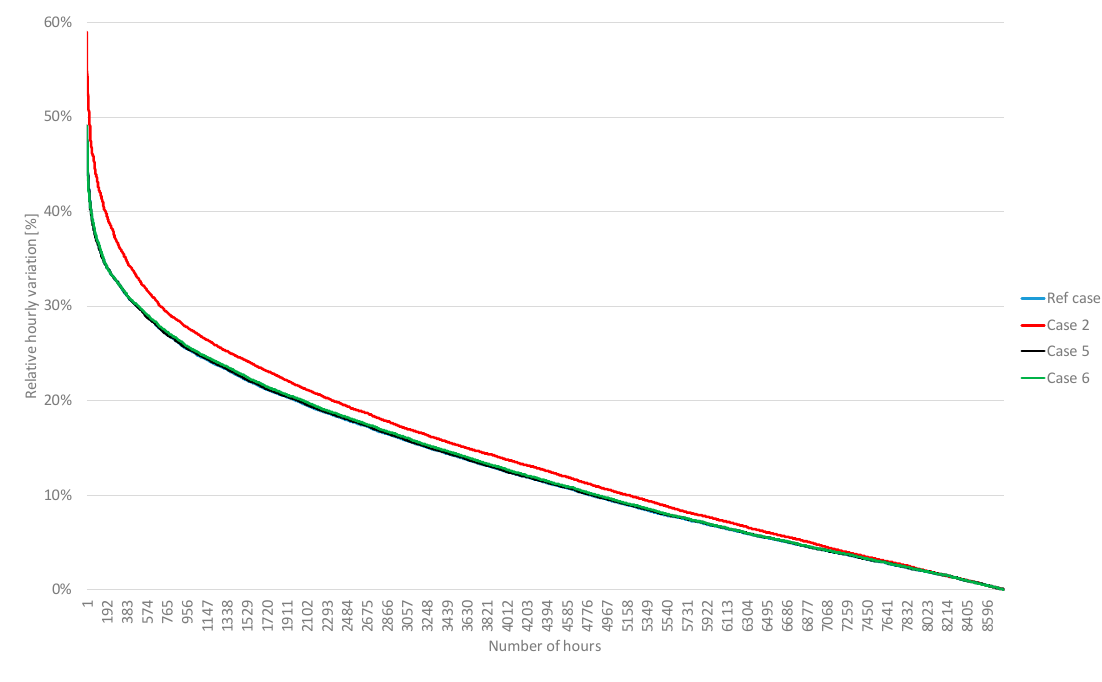
Figure A1. Relative load variation for the simulated year.